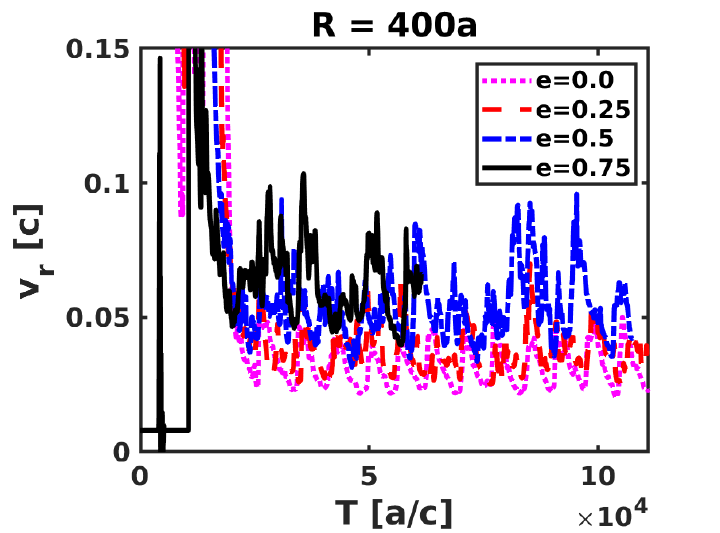
Figure 9. Radial velocity, averaged over s1, versus T at R = 400 a for different eccentricities.